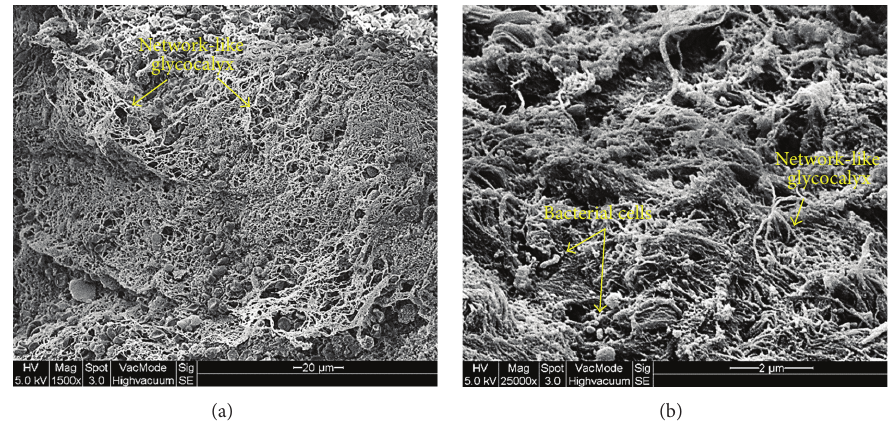
Figure 3: Microscopic evidence of bacterial biofilms on the tonsillar surface via SEM. (a) Overall image of biofilm from a patient with recurrent tonsillitis showing the layers of network-like glycocalyx (low magnification 1500x). (b) Representative image of biofilm from a patient with chronic tonsillitis showing bacterial cells attached to the surface of tonsillar cells and embedded in a network-like glycocalyx (high magnification 25000x). Arrows indicate the biofilm structures.